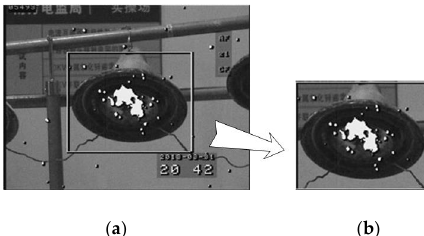
Figure 4. UV discharge image of a contaminated insulator: ( a ) original UV image and ( b ) image of the center area.